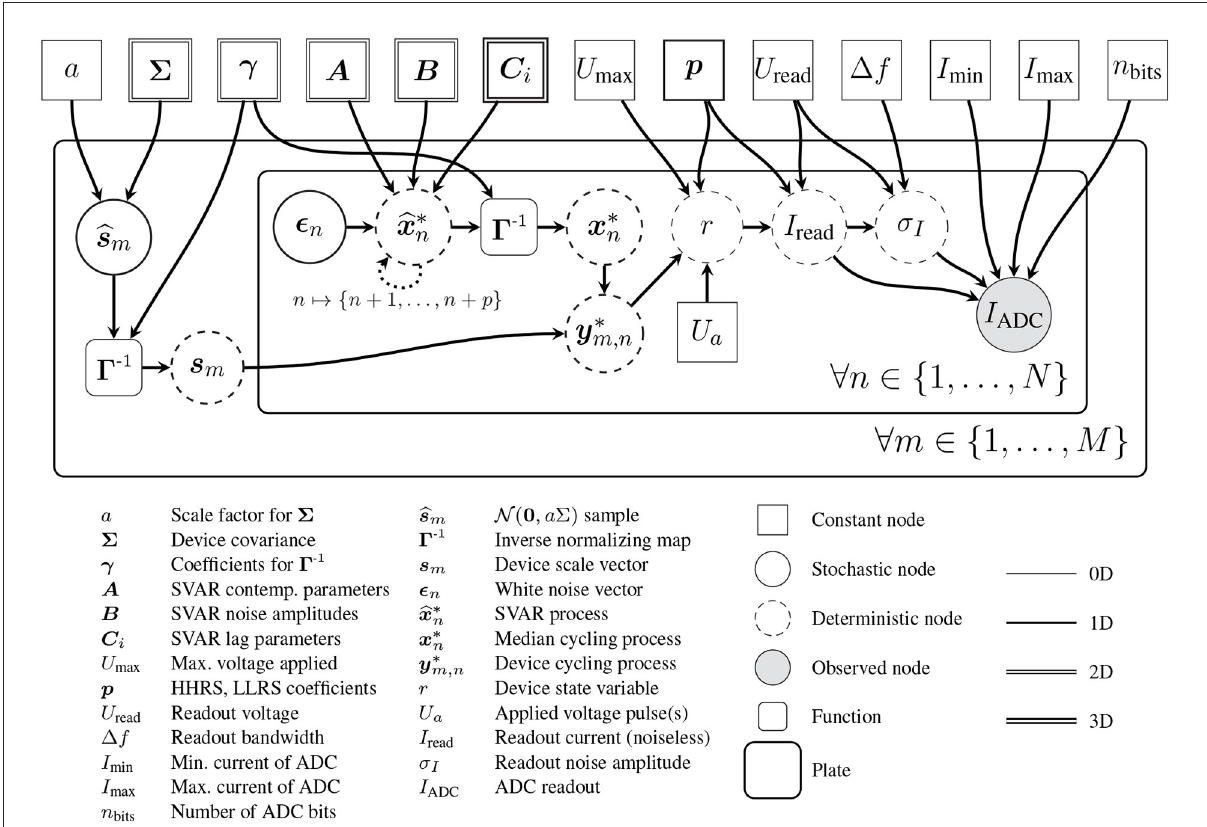
FIGURE7 Graphical model depicting the relationships between all parameters and latent variables involved in the stochastic synapse model. Plate notation is used to represent N switching cycles of M devices, each yielding an observed readout current. The dotted recurrent arrow denotes a connection to each of the p following frames, as needed by the history dependent stochastic process.